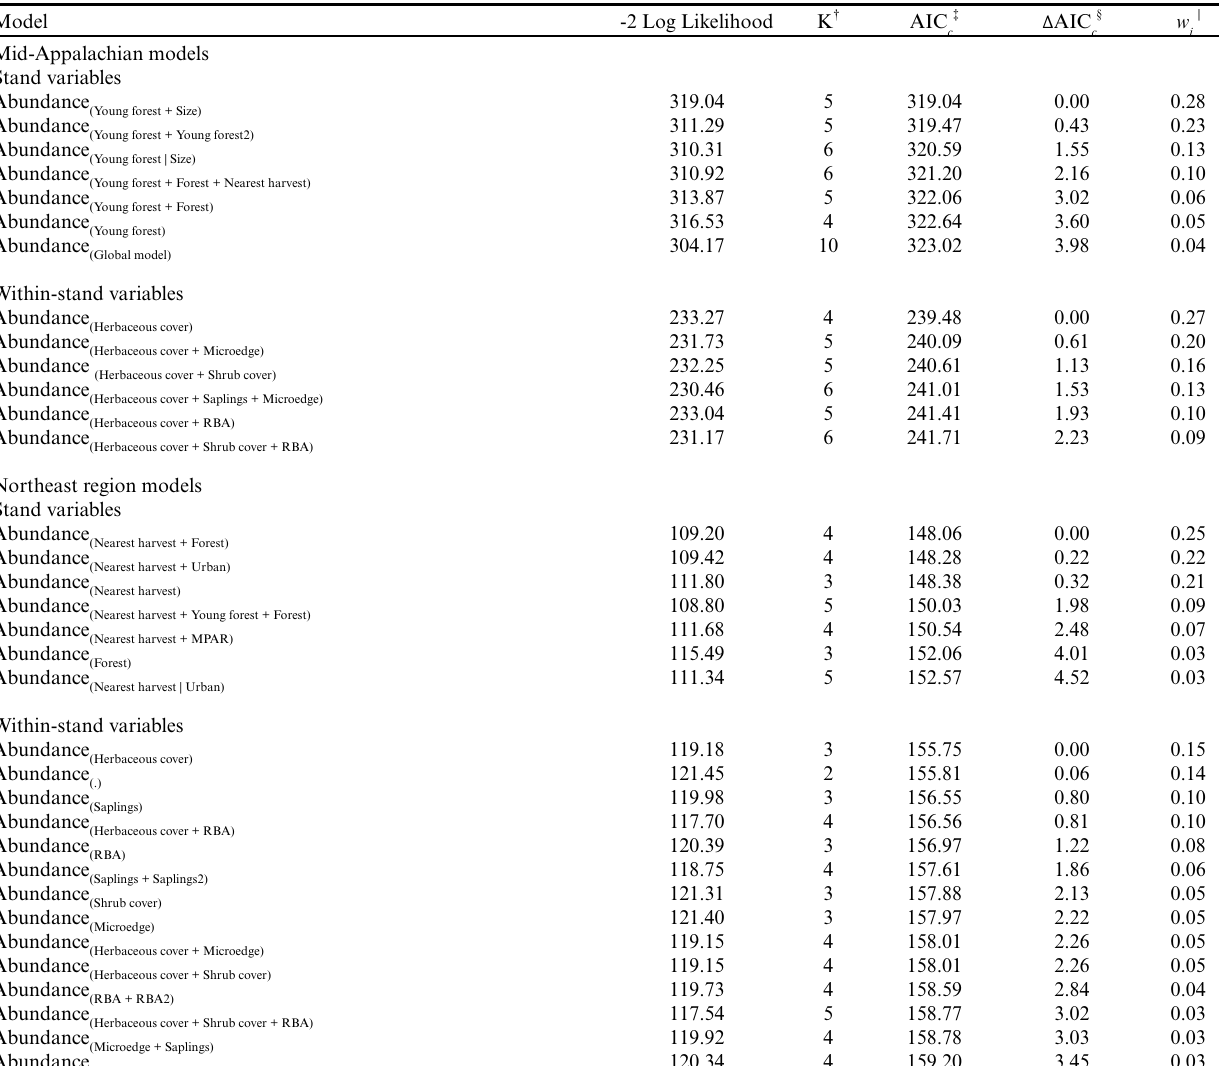
Table 2 . Ranked mid-Appalachian, i.e., Pennsylvania and Maryland, and northeast regional models explaining apparent abundance of Golden-winged Warblers ( Vermivora chrysoptera ) that incorporated stand and within-stand characteristics of regenerating stands, 2010-2011. Only the confidence set of candidate models is included. See Appendix 1 for the full suite of models and explanations of terms used in